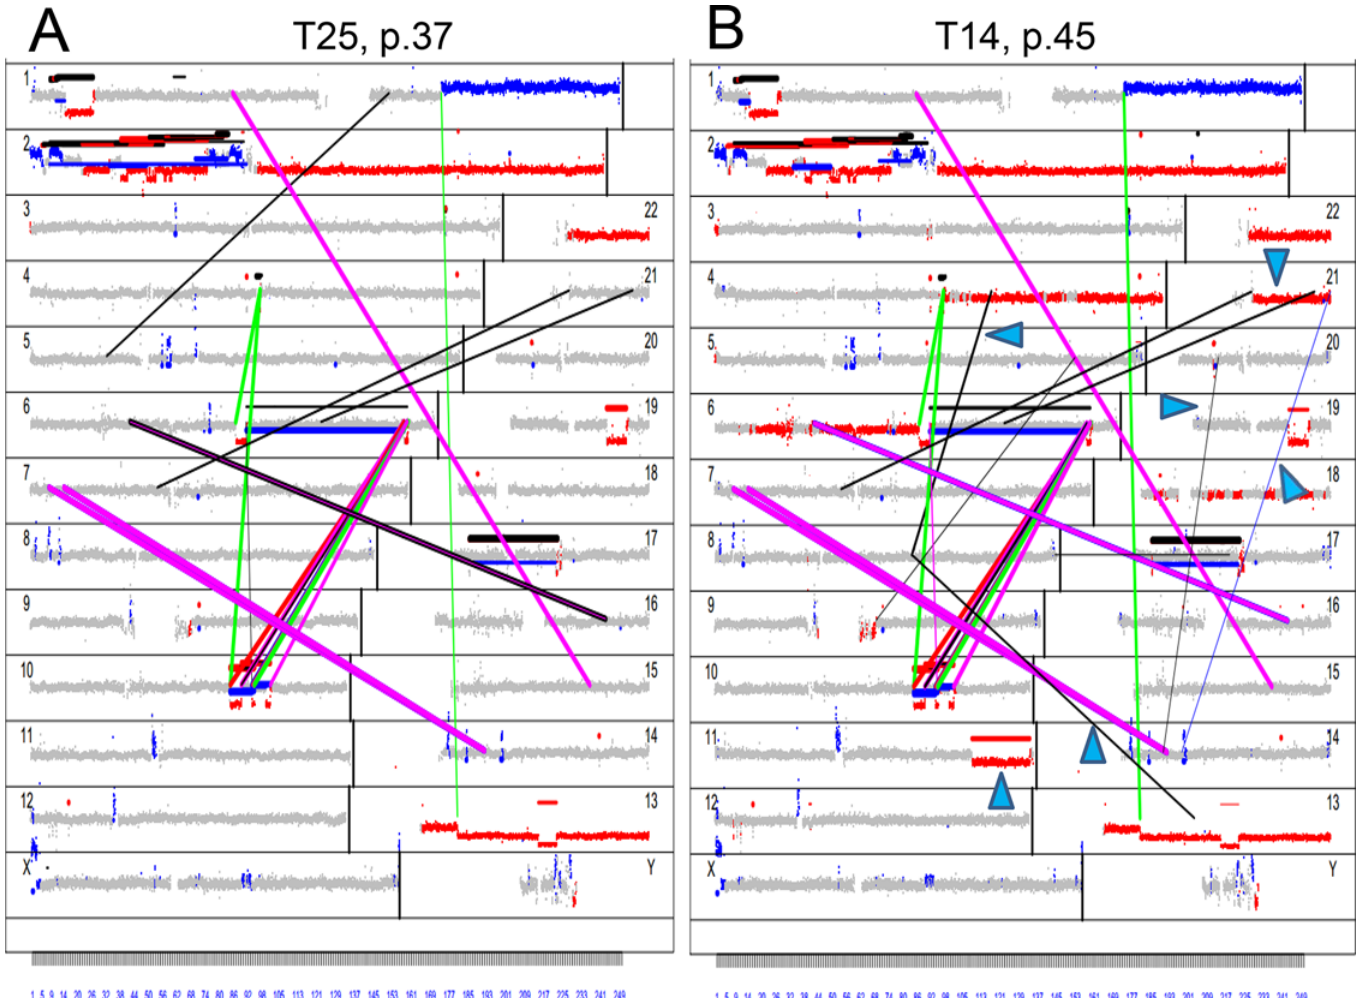
Fig 5. Genome plots showing landscape of DNA rearrangements in generated clones. A) Late passage of T25 clone expressing endogenous level of TOP2A. B) Late passage of clone T14 overexpressing TOP2A. Grey dots (counts) show frequency of distribution of reads in 30KB windows and breakpoints for all chromosomes (numbers are indicated). The X axis spans the length of the chromosome, the Y axis shows the number of reads for each window. Window counts are shown according to the prediction by CNV algorithm. Grey points are normal, red points correspond to deletions and blue points show gains. Lines connect bioinformatically identified breakpoints. The widths of the lines correlate with number of associated mate-pair reads. Color of the connecting lines indicates polarity of the joined chromosome. For intra-chromosomal events red shows forward direction for both pieces, green indicates inversion for one partner and blue shows inversion for both. For inter-chromosomal events, red connects the p-side piece from the larger chromosome to the q-side piece of the smaller chromosome in forward direction, green connects the q-side piece from the larger chromosome to the p-side piece of the smaller chromosome in forward direction, blue connects the p-side piece from the larger chromosome to the p-side piece of the smaller chromosome in reverse direction and magenta connects the q-side piece from the larger chromosome to the q-side piece of the smaller chromosome in reverse direction. Black indicates balanced translocations. Blue arrowheads point to selected DNA rearrangements that were acquired upon proliferation (absent in corresponding cells of earlier passage. (Fig 6A). In contrast, T14 cells overexpressing TOP2A demonstrated progressive accumulation of rearrangements with increasing passage (Figs 5B and 6B). The TOP2A gene itself was also affected in T14 of late passage (Table 1). However, the disruption of one allele did not result in significant decrease of expression of the protein, suggesting that exogenous integrated copy of the gene was mainly driving expression.